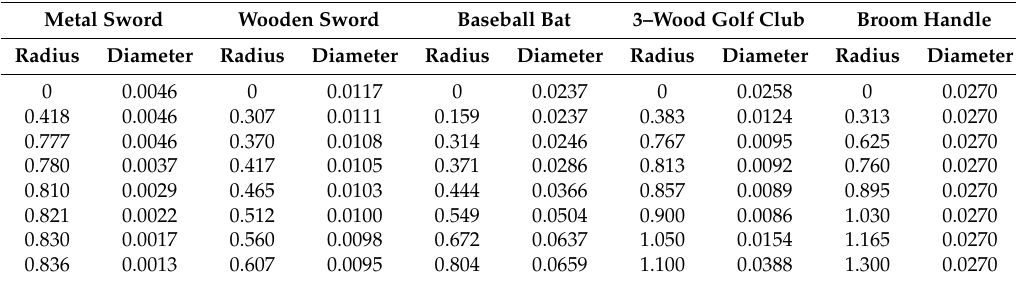
Table 2. Diameter and radius of compact sound sources for the preset objects. All values in metres. Correlation length = 5 d except for baseball bat, where correlation length = 2 d